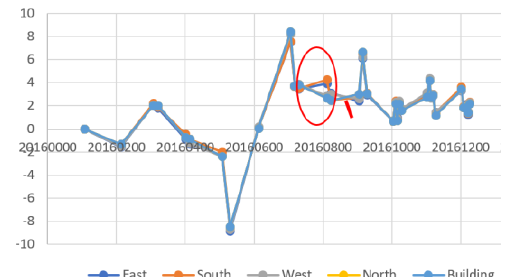
Figure 17. Displacement on Building 5 location, and its neighbours.